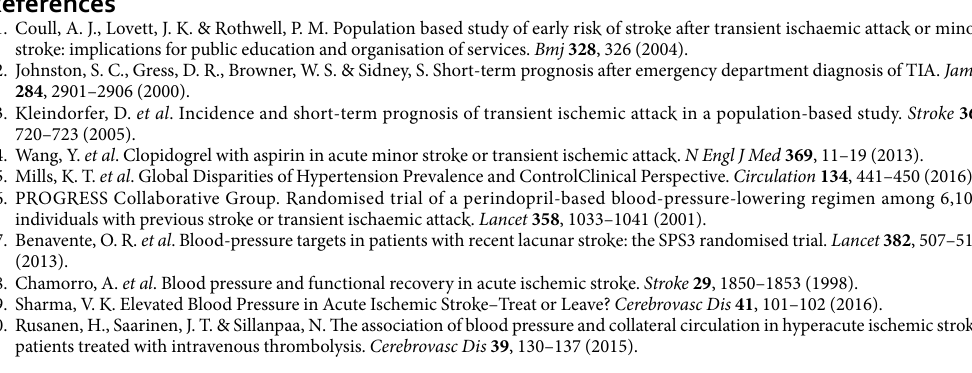
characteristics among dual and mono antiplatelet therapy in BP subgroup were compared by Chi-square tests or Fisher exact test for categorical variables and continuous variables were compared by Kruskal-Wallis test. For each group stratified by BP level, the differences between dual and mono antiplatelet therapy in the rates of stroke recurrence, combined vascular events, and bleeding during the 90 days follow up were evaluated by using crude and multivariable Cox proportional hazards models. Two-tailed p value less than 0.05 indicated statistical significance.